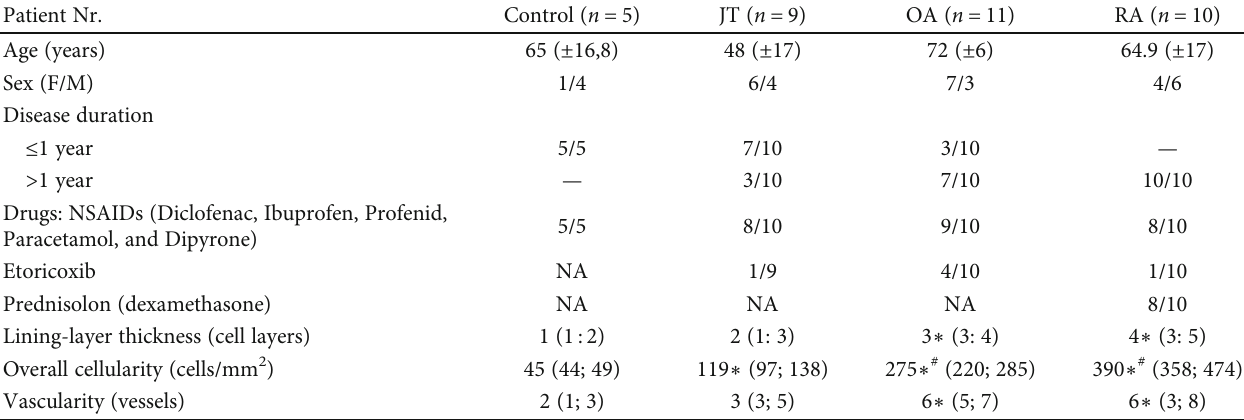
Table 1: The clinical and histological data characterizing the patients with joint trauma, osteoarthritis, and rheumatoid arthritis. Patient